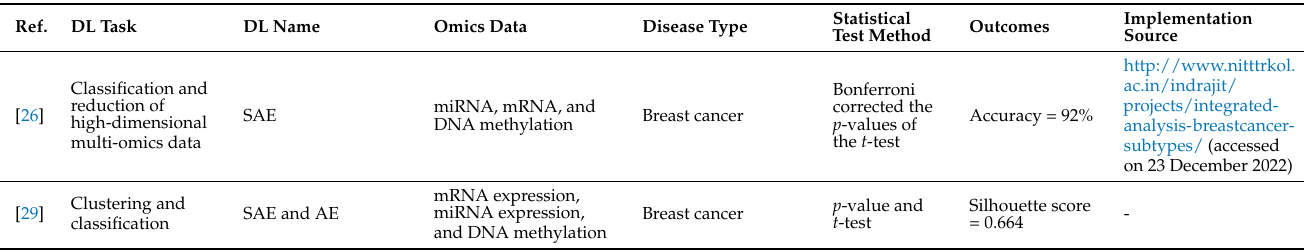
Table 1. Disease subtyping